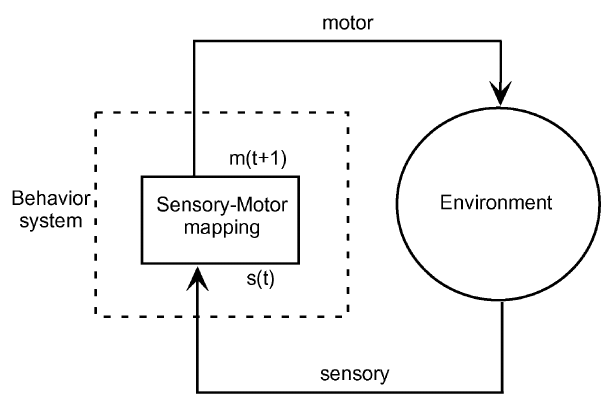
Figure 1. Sensory-motor coupling between behavior system and environment.